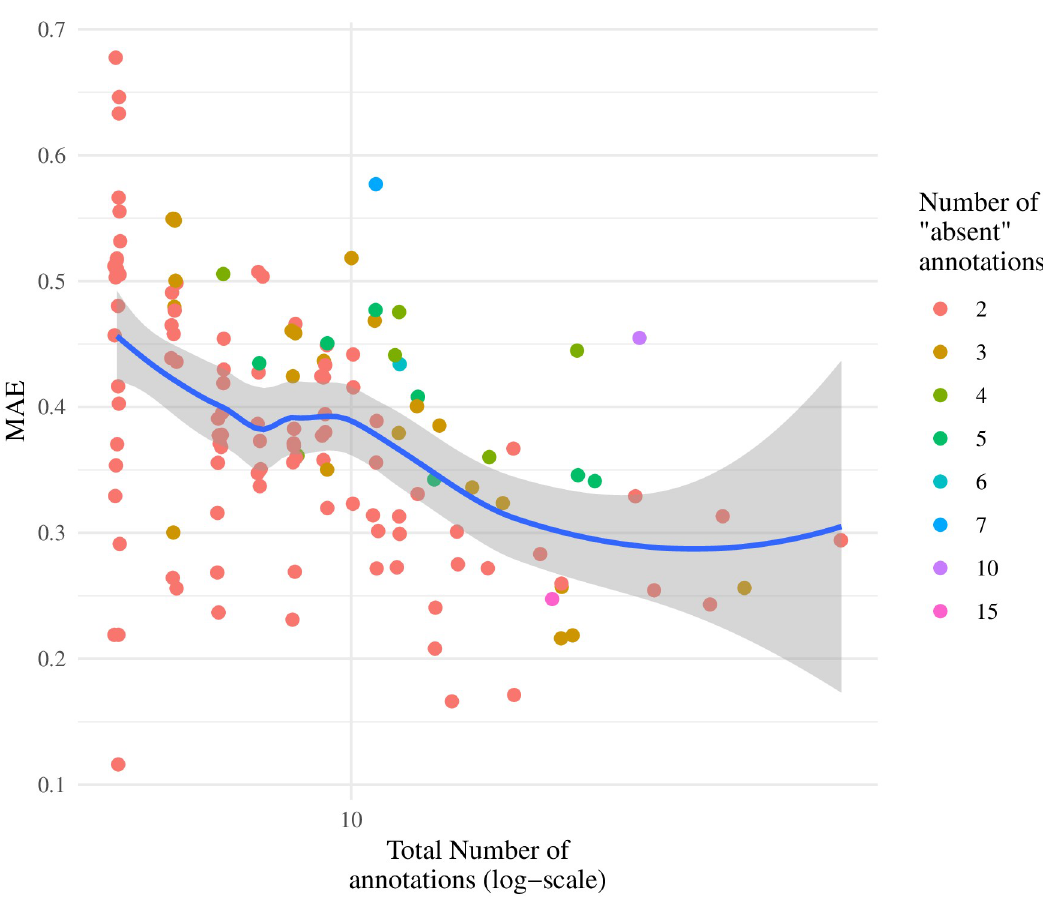
Fig 5. Mean Absolute Error versus number of annotations on 138 trees. Each point represents a single tree+function colored by the number of negative annotations (“absent”). The x-axis is in log-scale, and the figure includes a locally estimated scatterplot smoothing [LOESS] curve with a 95% confidence